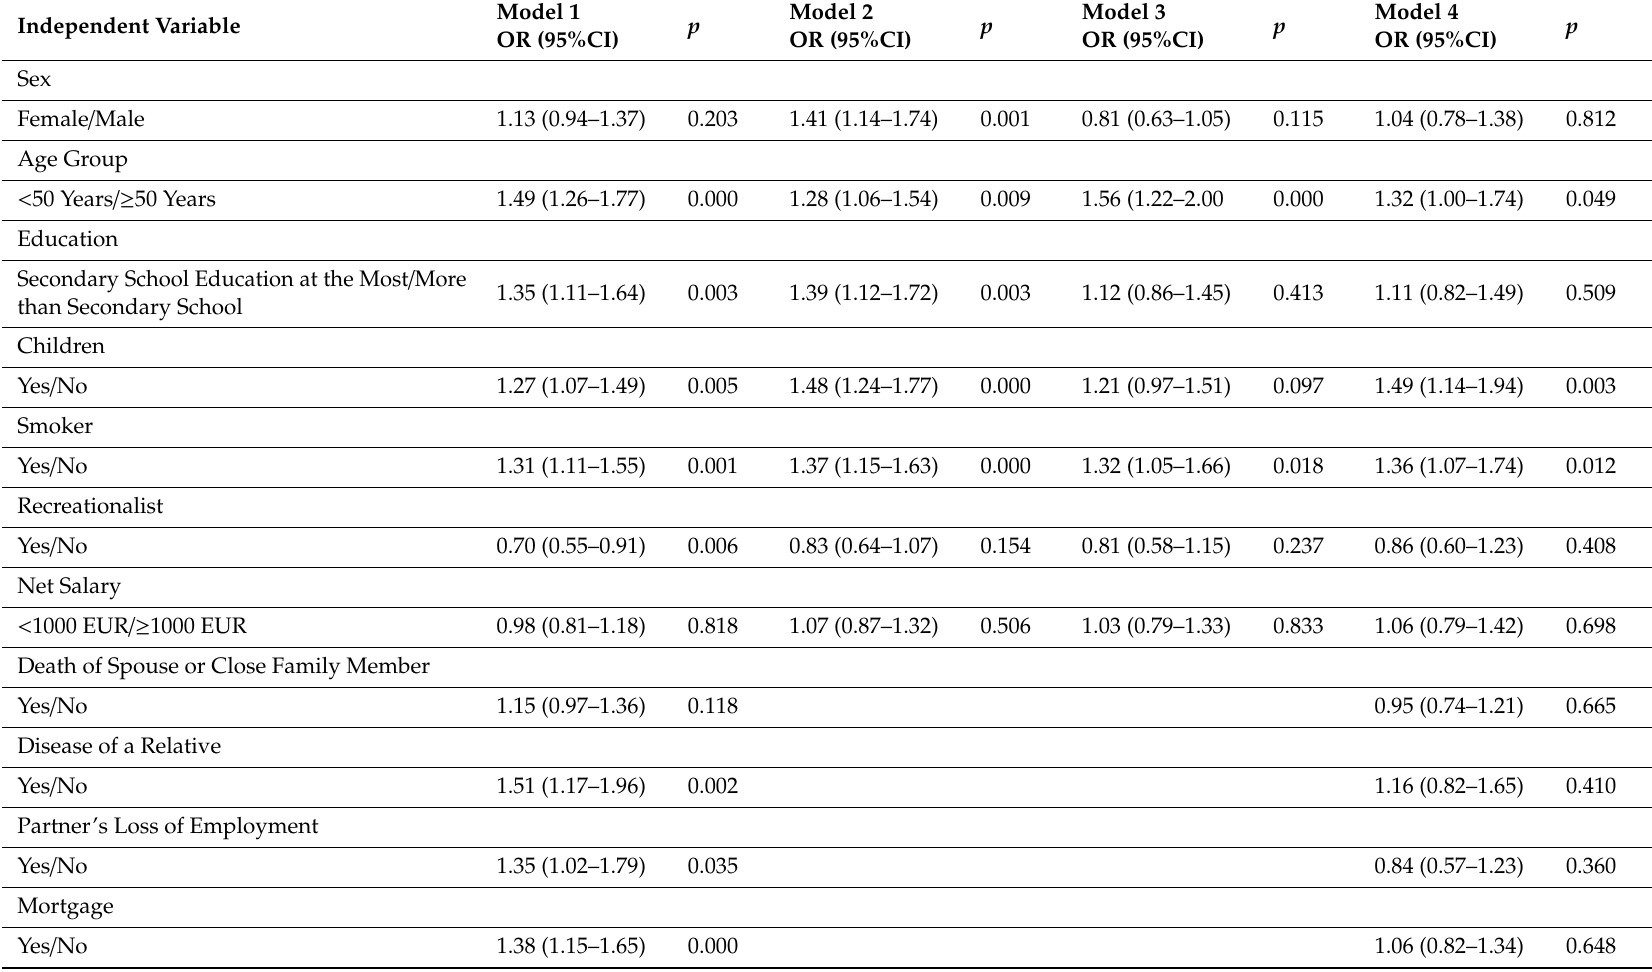
Table 4. Logistic regression models with odds ratios (ORs) and their 95 confidence interval (CI) for associations between sickness presence and life events (Model 1), work related and psycho-social factors (Model 2), health measures (Model 3), and the full model (Model